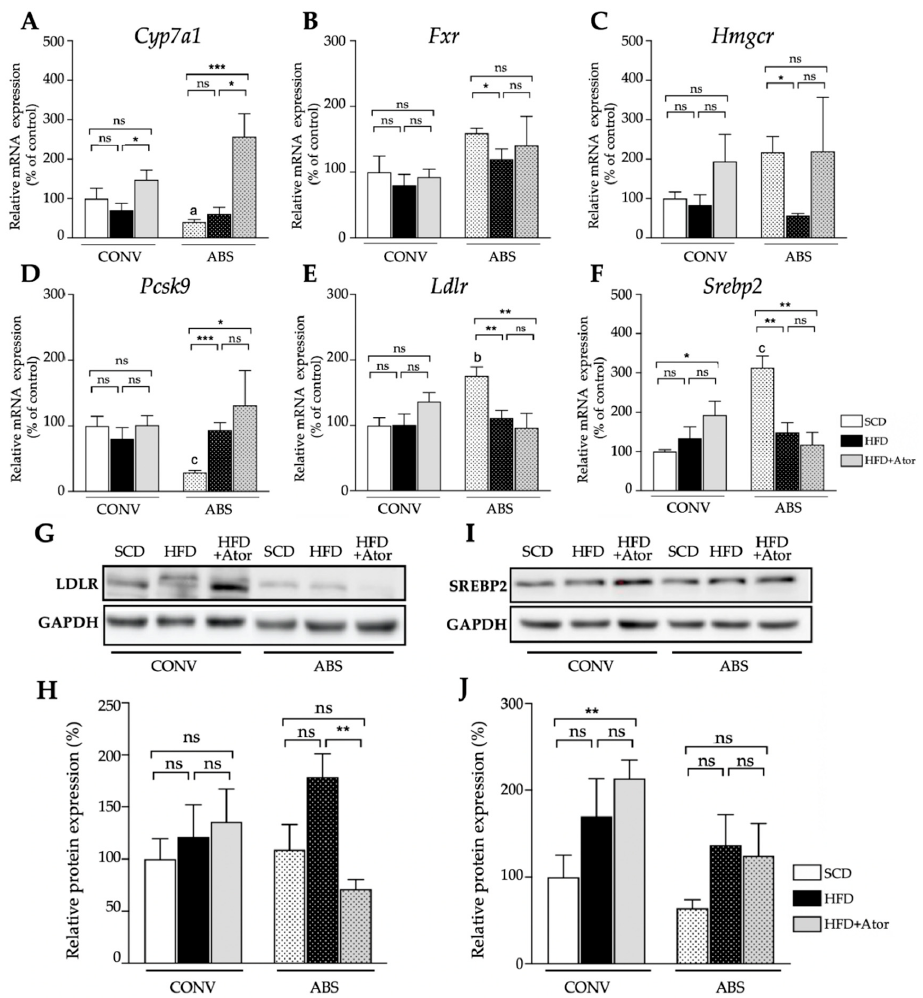
Figure 6. Hepatic genes and proteins. ( A – F ): Hepatic expression of genes involved in cholesterol metabolism and their alteration upon HFD + atorvastatin treatment in CONV ( n = 15) and ABS ( n = 19) mice. ( G – J ): Hepatic protein expression of sterol regulatory element-binding protein 2 ( Srebp 2) and ldl receptor ( Ldlr ) gene expression by atorvastatin in ABS ( n = 12) mice as compared to CONV ( n = 12) mice. The protein levels of srebp2 and ldlr were further evaluated by Western Blot (B). Error bars indicate SEM. * = p < 0.05, ** = p < 0.01; *** = p < 0.001.